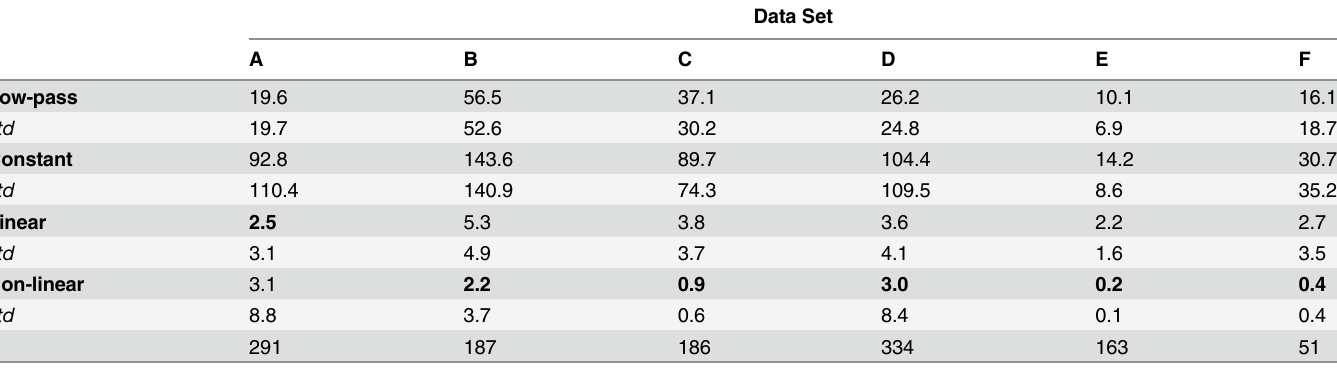
Table 3. MSE for the different analysis methods calculated using data points before and after the